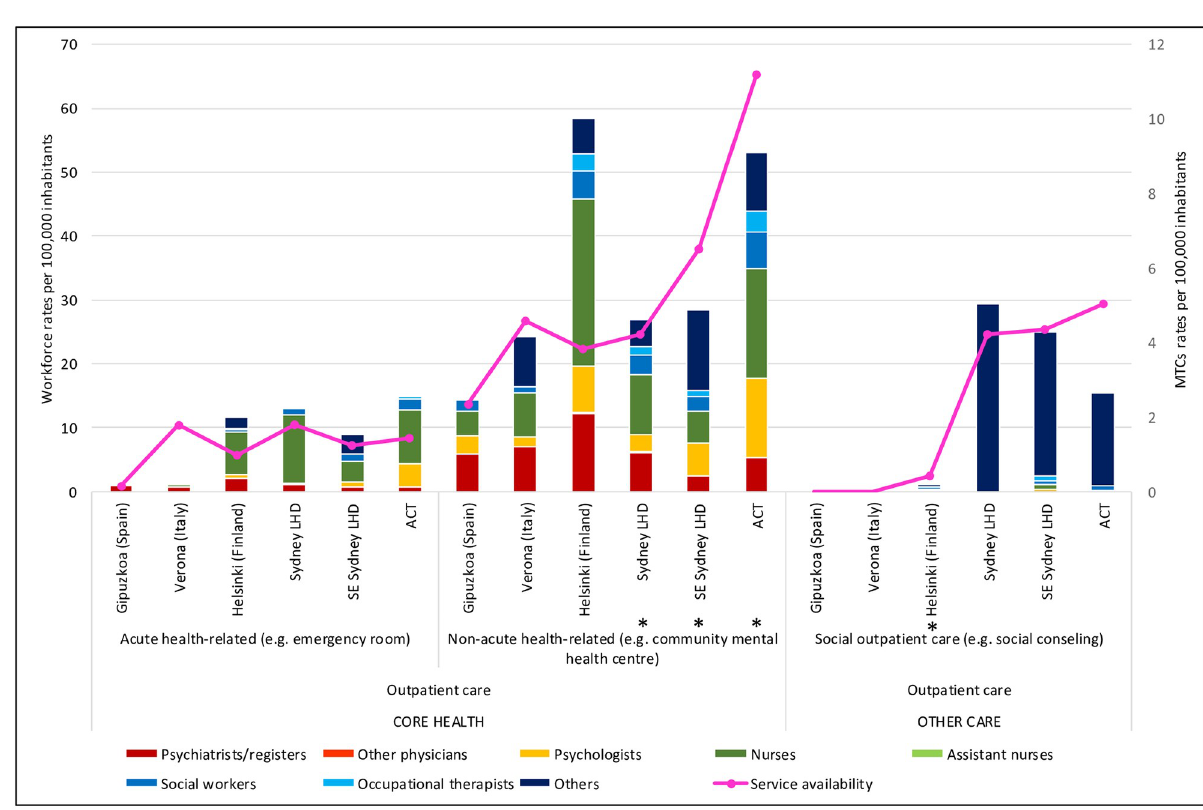
Fig 2. Workforce rates and availability in adult mental health services for outpatient care in the six study areas. � Missing data.